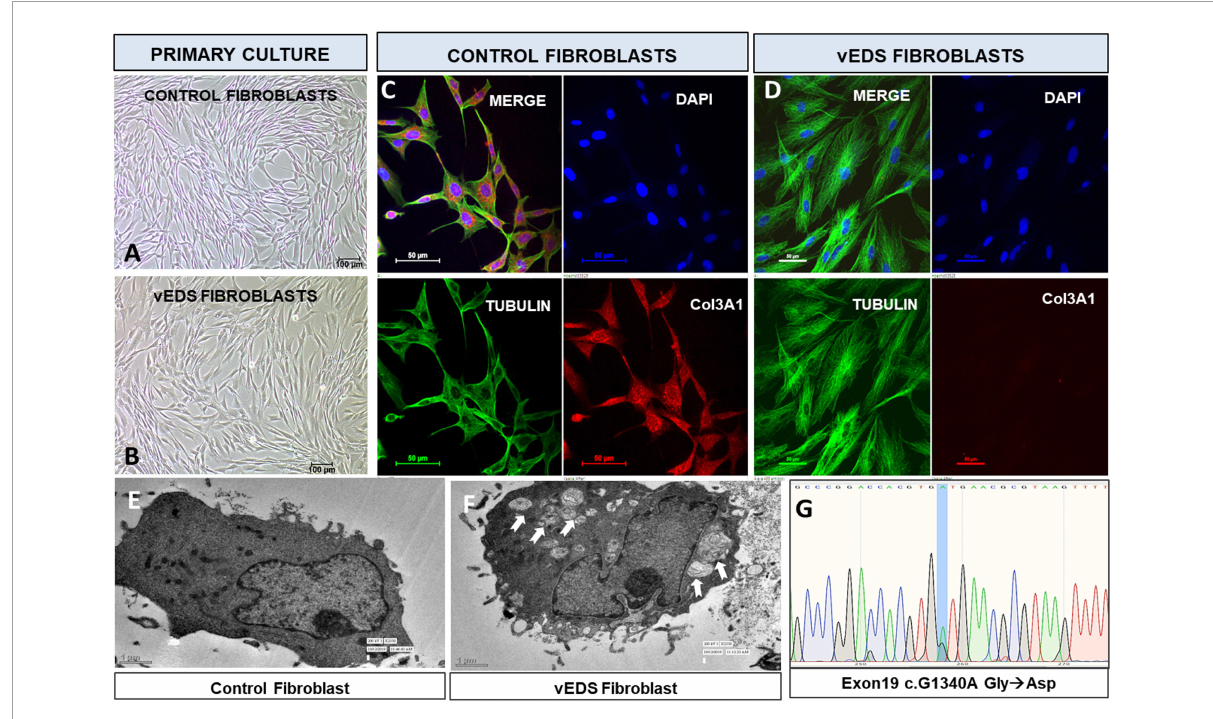
FIGURE2 Primary culture of skin derived fibroblasts from (A) age matched control (B) suspected vEDS patient. Immunofluorescence analysis of fibroblasts show (C) presence of Col3A1(Red) control fibroblasts whereas (D) patient fibroblasts show absence of Col3A1. Transmission electron microscopy of (E) control fibroblasts with normal morphology, (F) vEDS fibroblasts with altered morphology, arrows show intracytoplasmic lamellar vacuolar bodies. (G) Sequences of wild-type (1340-G) and mutant (1340-A) COL3A1 cDNA derived from patient skin fibroblasts. As vEDS patient is heterozygous for COL3A1 c.1340G > A mutation, sequencing of the region harboring the mutation results in detection of both guanine and adenine at position 1340. The G > A mutation leads to an exchange from glycine to aspartic acid at the protein